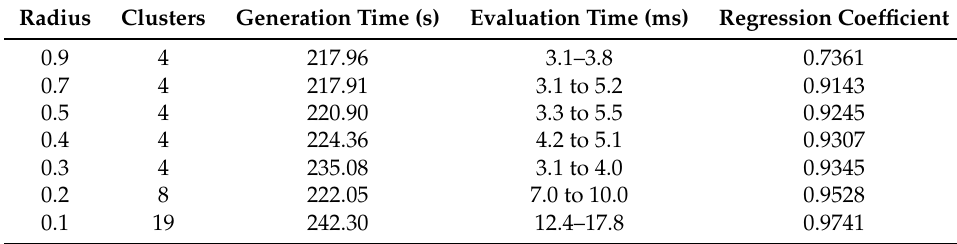
Table 4. Comparison table of the Takagi–Sugeno method with three inputs and three outputs.